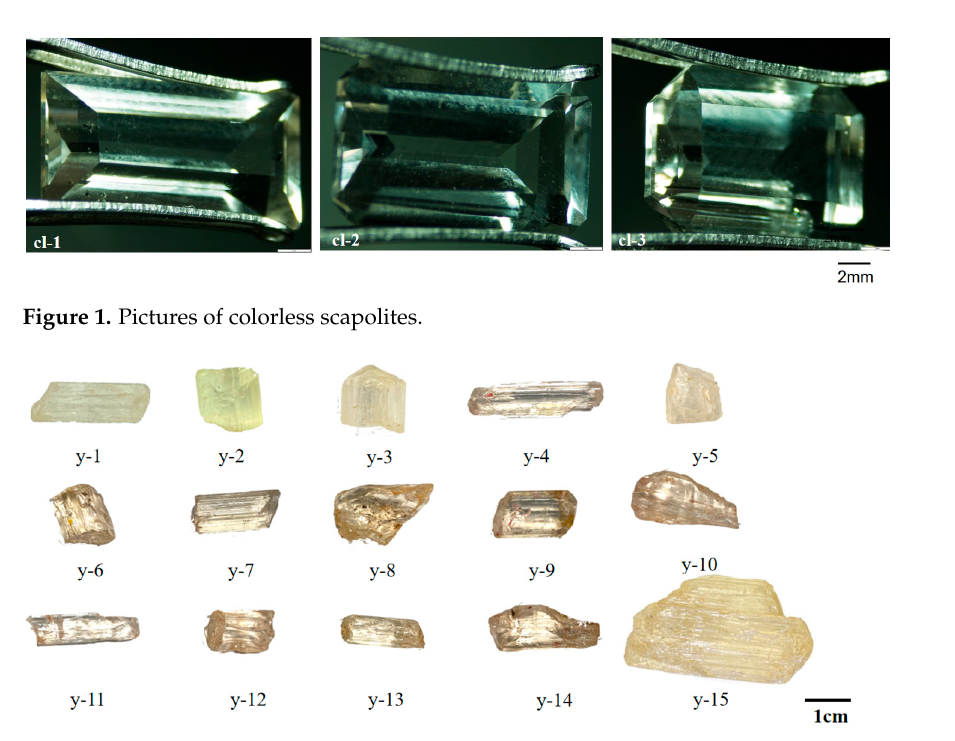
Figure 2. Pictures of yellow scapolites.